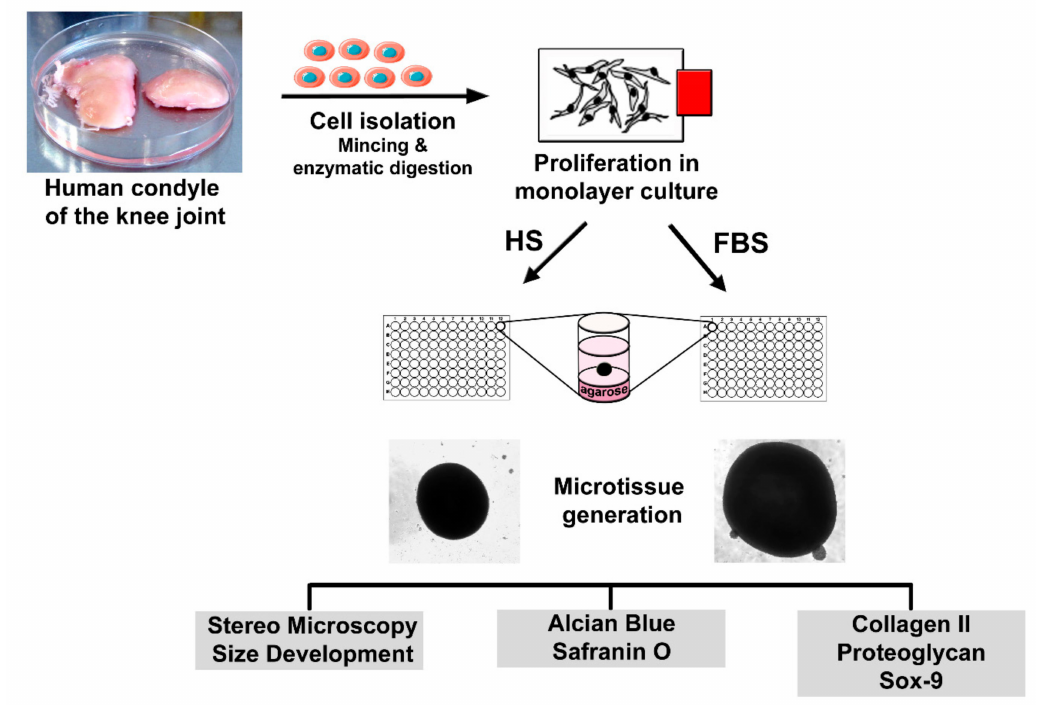
Figure 1. Experimental setup for the generation and analysis of sca ff old-free microtissues derived from primary human articular